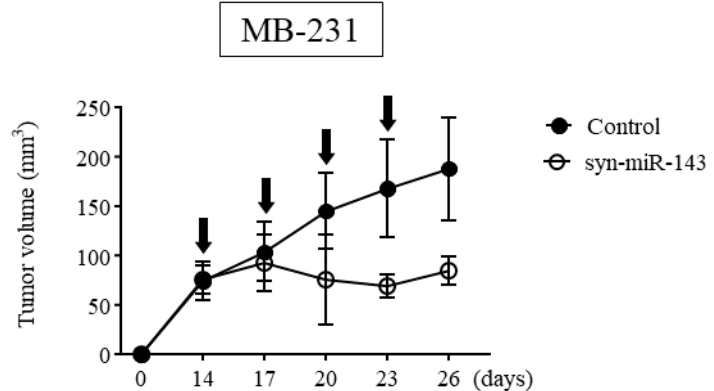
Figure 2. The result of anti-tumor effect of syn-miR-143 on breast cancer xenograft tumor in vivo. Time course of tumor size in MB-231 cell-xenografted nude mice treated with control RNA or syn- miR-143. Arrow represents a treatment with control RNA (1.5 mg/kg/administration) or syn-miR-143